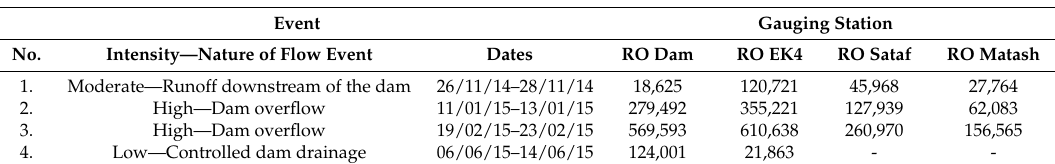
Table 2. Total measured runoff (m 3 ) at the monitoring stations in the study site during all studied flow events.